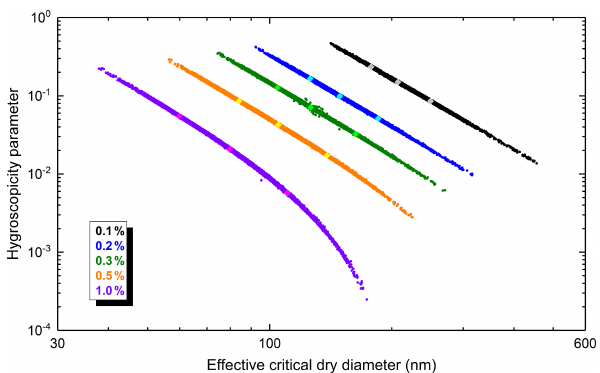
Figure 6. Relationship of the hygroscopicity parameter to the ef- fective critical dry particle diameter ( d c , eff ) derived for supersatu- rations of 0.1%, 0.2%, 0.3%, 0.5% and 1.0%. The three diamond symbols that appear along each line of data represent, in order of increasing d c , eff , the data pairs for the 10th and 90th percentiles, the 50th and 50th percentiles, and the 90th and 10th